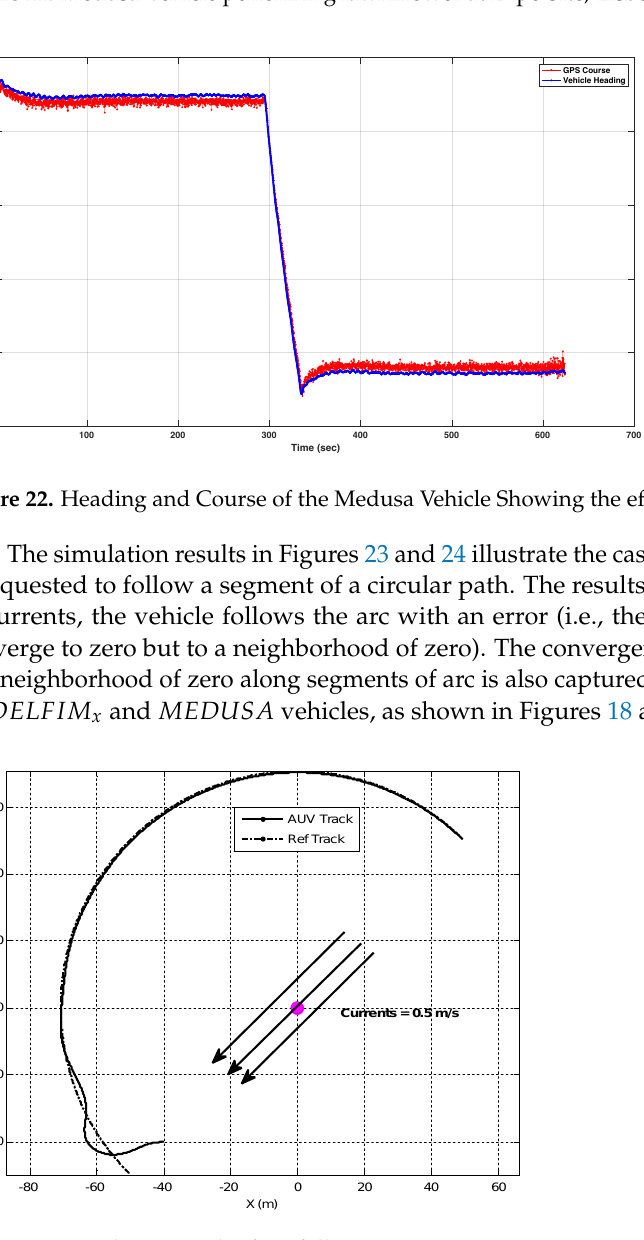
Figure 23. Simulation result of arc